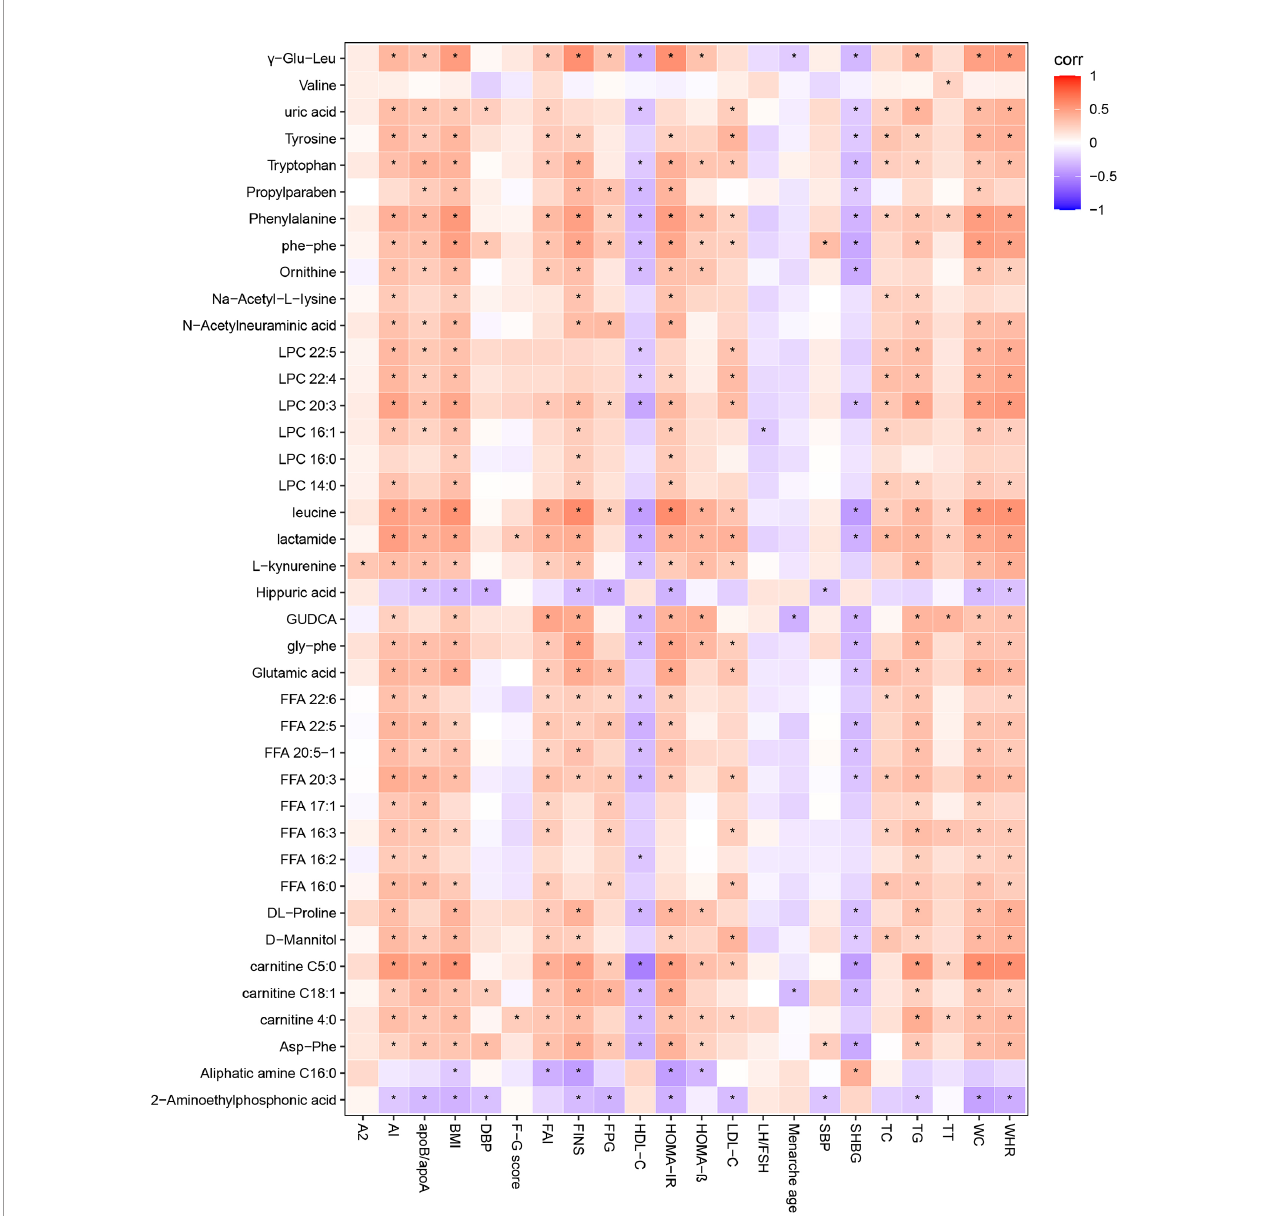
FIGURE 7 | Correlation heatmap of differential metabolites and differential clinical indicators in PCOS vs . PCOS-MS. In this picture, red represents corr = 1, blue represents corr = – 1, and white represents corr = 0. “ * ” in the fi gure represents P < 0.05. The X-axis stands for differential metabolomics, and the Y-axis stands for differential clinical data in PCOS vs .